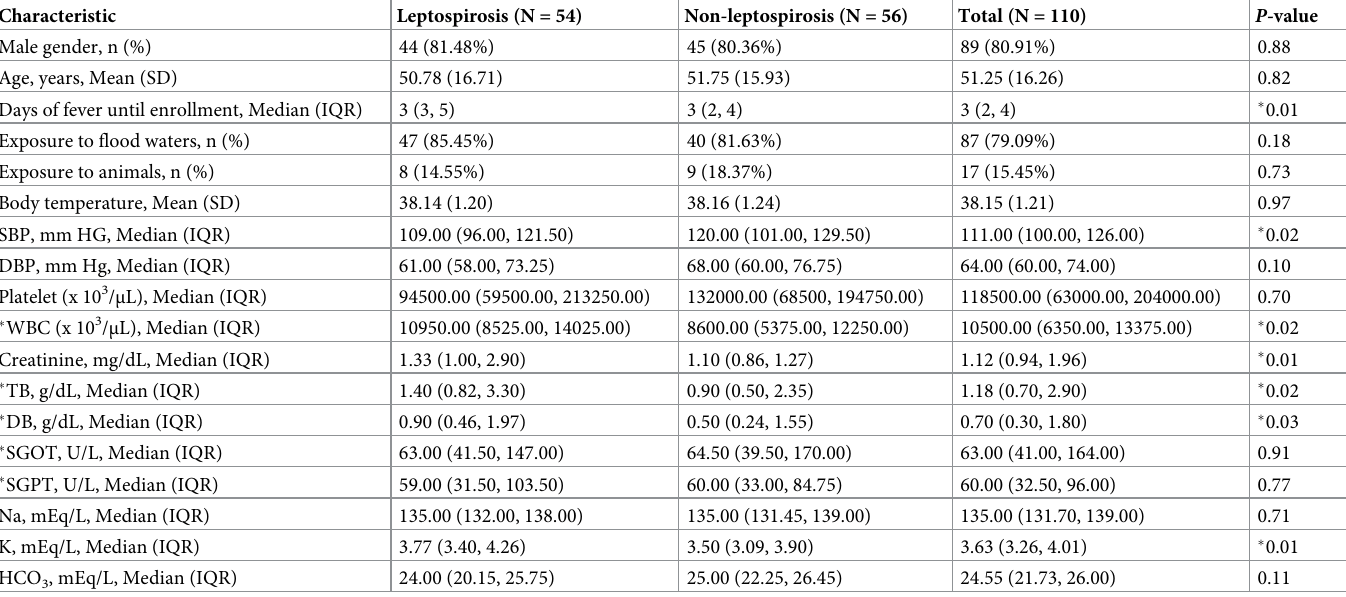
Table 1. Characteristics of the qPCR positive and negative groups with patient clinical and laboratory data.